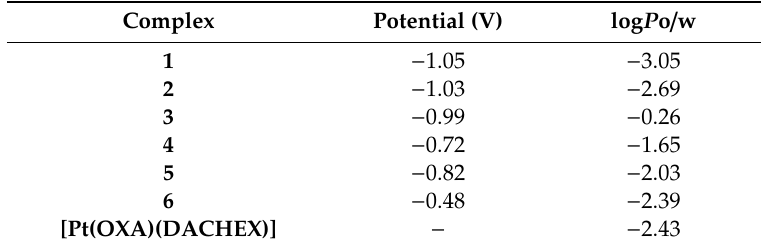
Table 3. Cathodic reduction potentials (E pc , Volt, values normalized vs. SCE) for the complexes 1 – 6 and log P o / w (determined by the shake-flask method).